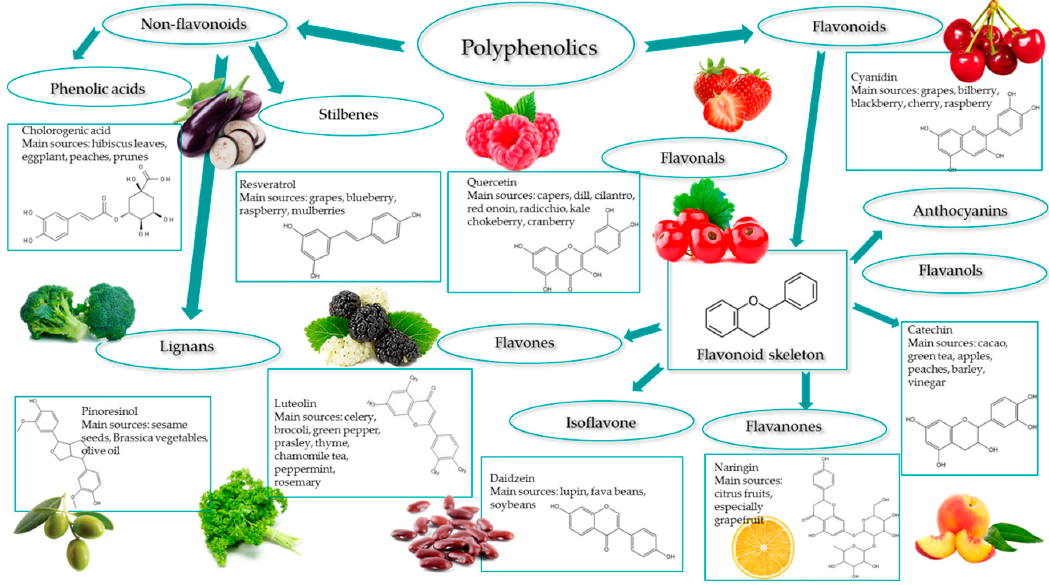
Figure 1. Polyphenols: classification and main sources (adapted from Goszcz, K. et al., 2015 [5]).